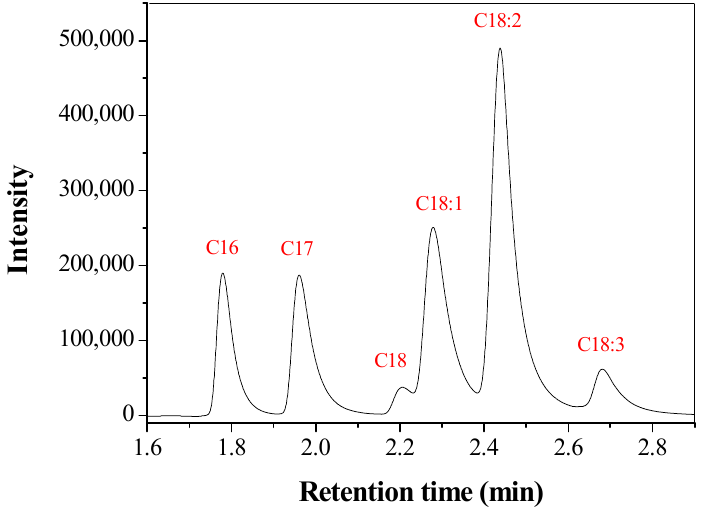
Figure 13. Chromatographic profile of esters formed in reactions catalyzed by LU immobilized on CTA during 24 h. Chromatographic conditions: column oven temperature: 210 °C. Split injector: 250 °C, split ratio 1:10; injected volume: 1.0 μ L.